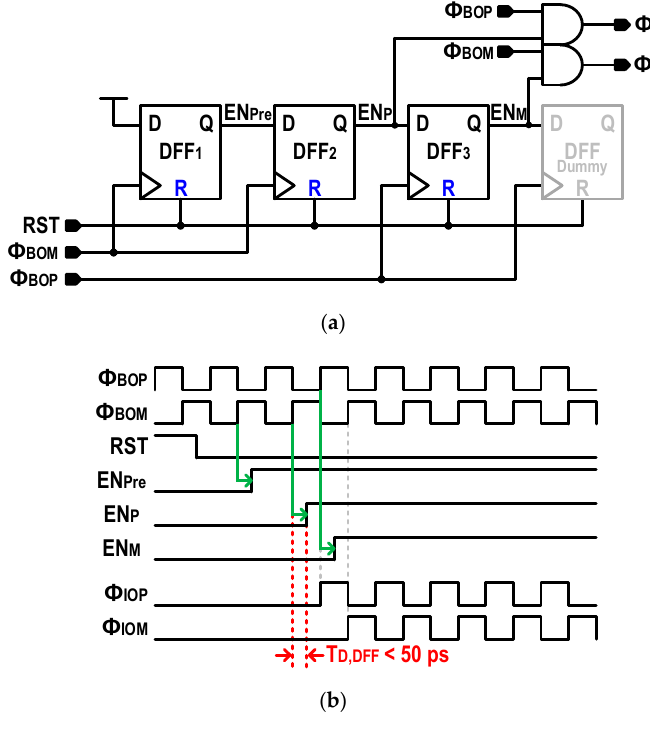
Figure 8. Clock initial logic. ( a ) Block and ( b ) timing diagrams.